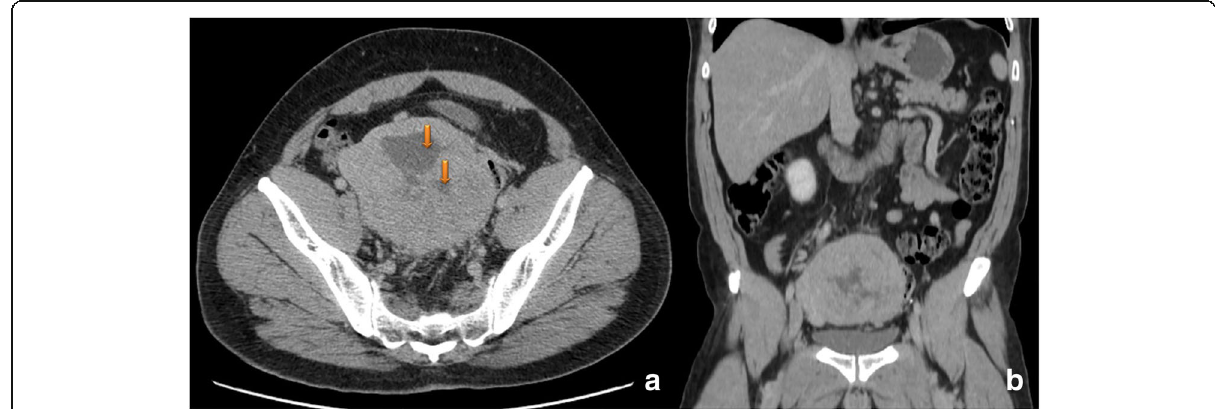
Fig. 3 Typical imaging manifestations of SFT of the peritoneum. Axial ( a ) and coronal ( b ) contrast material-enhanced CT scan shows a well- defined intensely enhancing mass in the pelvis with central nonenhancing areas of necrosis (arrows)